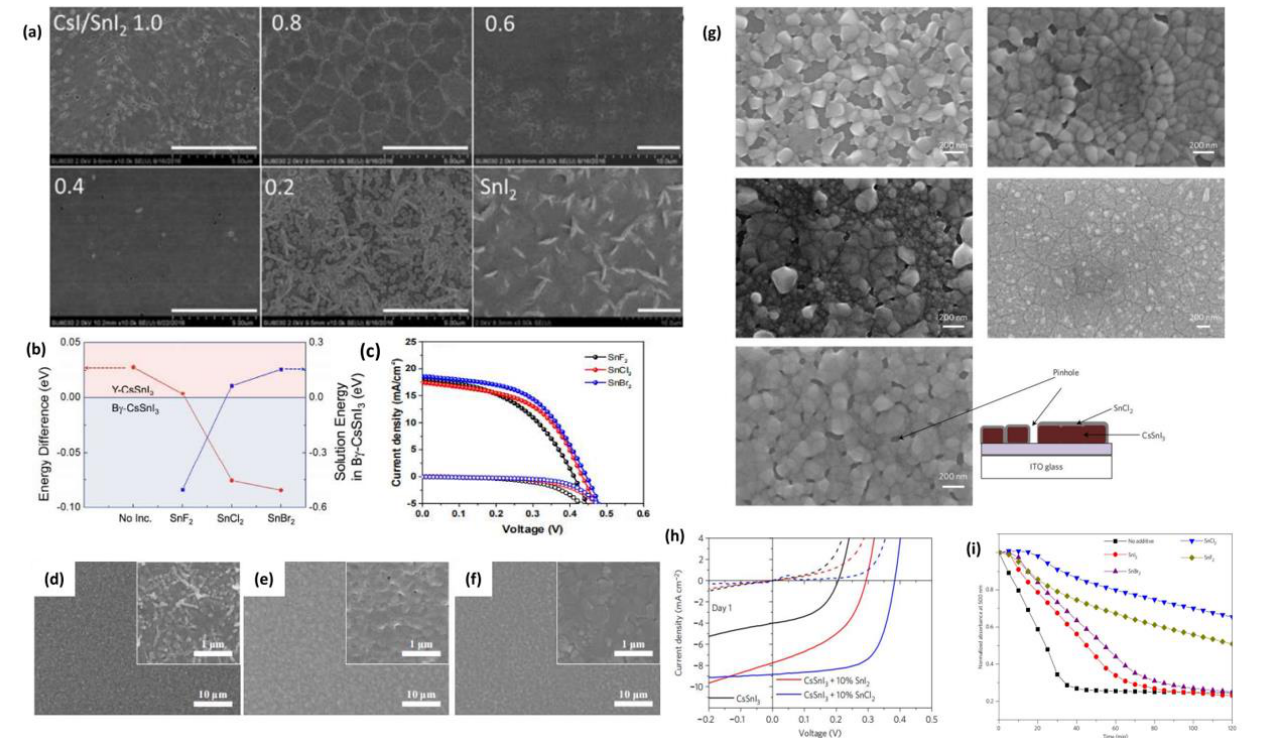
Figure 3. ( a ) SEM pictures of CsSnI 3 perovskite films with different molar ratios of CsI/SnI 2 [57]. ( b ) Total energy discrepancy between different phases of CsSnI 3 . ( c ) Performances of CsSnI 3 PVSCs with different additives. The SEM surface pictures of CsSnI 3 perovskite films with different additives ( d ) SnF 2 , ( e ) SnCl 2 , and ( f ) SnBr 2 additives [58]. ( g ) SEM images of CsSnI 3 films prepared under different conditions containing no tin halide additive, 10 mol% SnI 2 , 10 mol% SnBr 2 , 10 mol% SnF 2 , and 10 mol% SnCl 2 . ( h ) J−V performance and ( i ) stability of CsSnI 3 PVSCs prepared under different condi- tions containing without additive, 10 mol% SnI 2 , 10 mol% SnBr 2 , 10 mol% SnF 2 , and 10 mol% SnCl 2 [27].